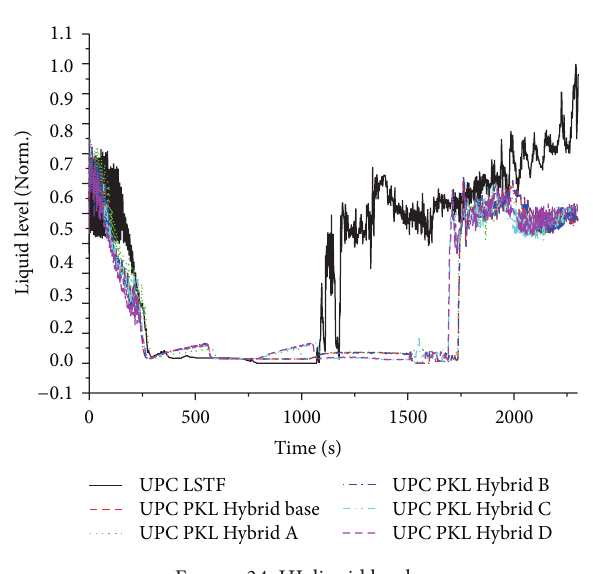
Figure 34: HL liquid level.